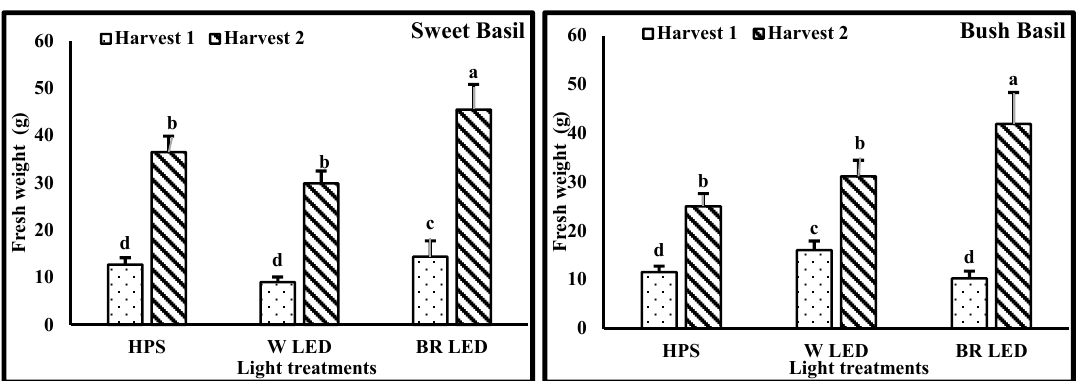
Figure 7. The effect of light treatments and harvest stage on plant fresh weight fresh weight (FW) of sweet basil (LSD = 5.2 for the light treatment, LSD = 4.3 for the harvest stage) and bush basil (LSD = 4.4 for the harvest stage and LSD = 7.7 for the interaction between the light treatments and harvest stage). Different letters denote significant differences between treatments ( p < 0.001).